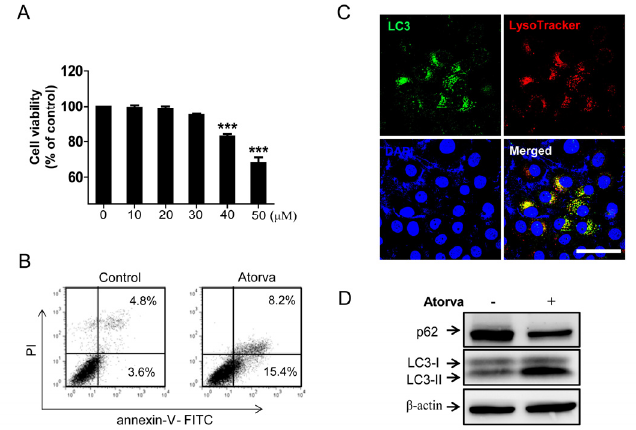
Figure 4. Inhibition of autophagy induced by atorvastatin improves atorvastatin-induced apoptosis in J82 bladder cancer cells. ( A ) The cell viability assay to examine the cytotoxic effects of atorvastatin in J82 cells. Differing concentrations of atorvastatin (zero, 10, 20, 30, 40 and 50 μ M) were administrated over 48 h. The values of cell viability are represented by the mean percent of control ± SEM ( n = 3, *** p < 0.001); ( B ) Evaluation of apoptotic cell death after treatments with 30 μ M of atorvastatin by flow cytometry analysis with FITC-conjugated annexin-V and PI staining. Relative proportions of both early and late apoptosis are indicated in right lower and right upper quadrant, respectively in each treatment group; ( C ) Immunocytochemistry for the co-localization of LC3 puncta (green) and Lysotracker (red, demarcation for the lysosome) in J82 cells after atorvastatin treatments (30 μ M) for 24 h. DAPI was used for nucleus staining. Scale bar = 100 μ m; ( D ) Western blot analysis of autophagosome formation markers p62/SQSTM1, LC3-I and LC3-II in untreated (control) and atorvastatin (30 μ M) treated J82 cells; ( E ) Phase contrast images of untreated J82 cells (control), treated J82 cells with 20 μ M of bafilomycin A1 (BFA1), 20 μ M of atorvastatin (Atorva) and both these agents (Atorva + BFA1). Scale bar = 200 μ m; ( F ) The clonogenic assay to compare the in vitro cell survival potential after treatment with 20 μ M of atorvastatin and combined treatment with 20 μ M of atorvastatin and BFA1 for 12 days. The colony is defined as containing at least 50 individual cells. Photographs represent each experimental group stained with the clonogenic assay kit; ( G ) The cell viability assay to examine the cytotoxic effects of 20 μ M of BFA1, 20 μ M of atorvastatin and both these agents. The values of cell viability are represented by the mean percent of control ± SEM ( n = 3, *** p < 0.001); ( H ) Flow cytometry analysis with FITC- conjugated annexin-V and PI staining to evaluate apoptotic cell death in J82 cells treated with 20 μ M of atorvastatin and both 20 μ M of BFA1 and atorvastatin for 48 h. Relative proportions of both early and late apoptosis are indicated in right lower and right upper quadrant, respectively in each treatment group; ( I ) Western blot analysis of apoptotic markers procaspase-3, total PARP and cleaved-PARP in J82 cells treated with 20 μ M of BFA1, 20 μ M of atorvastatin and both these agents for 48 h; ( J ) Cell viability assay to compare the cytotoxic effects in J82 cells treated with 20 μ M of CQ, 20 μ M of atorvastatin and both agents. The values of cell viability are represented by the mean percent of control ± SEM ( n = 3, *** p <